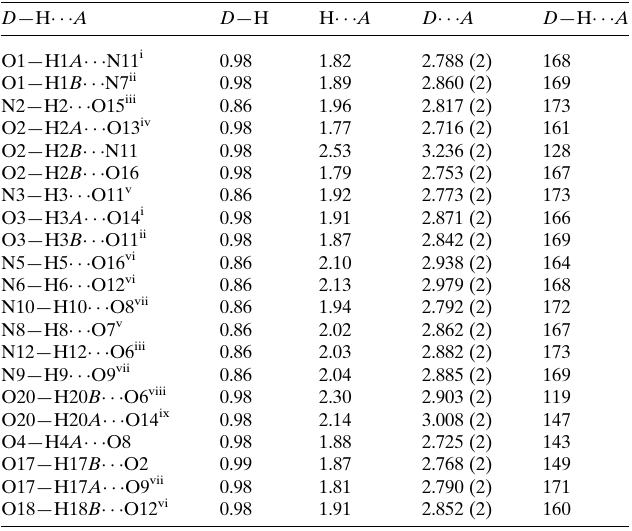
Table 1 Hydrogen-bond geometry (A˚ , (cid:3)